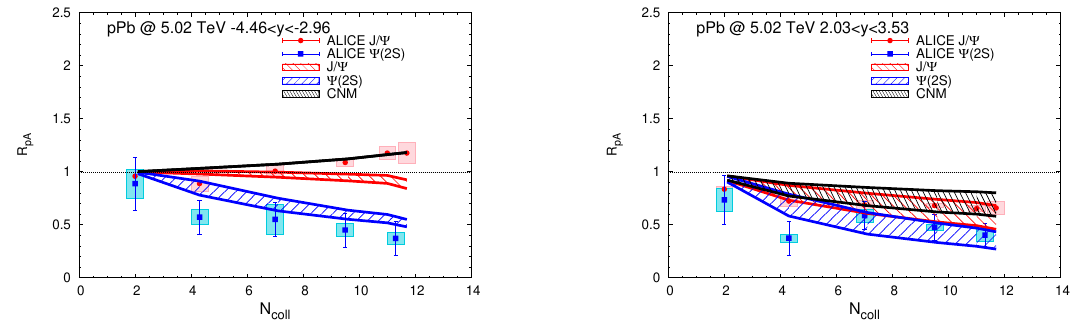
Figure 4 . Centrality-dependent R p A for J= (red bands) and (2 S ) (blue bands) in 5.02 TeV p -Pb collisions, compared with experimental data [14{16]. The left (right) panel is for backward (forward) rapidity. The bands are due to (anti-) shadowing from EPS09 LO/NLO [47, 48] at forward (backward) rapidity, as illustrated by the black bands which do not include (cid:12)nal-state e(cid:11)ects.